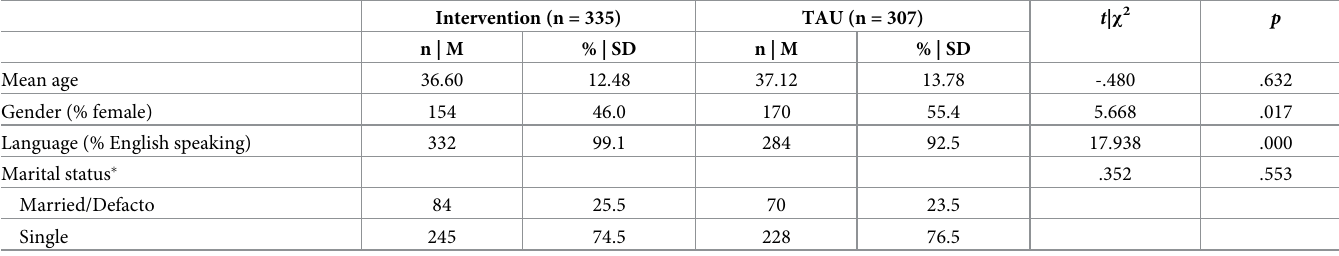
Table 2. Demographic characteristics of patients with personality disorder at the intervention site (n = 335) and the TAU site (n = 307).